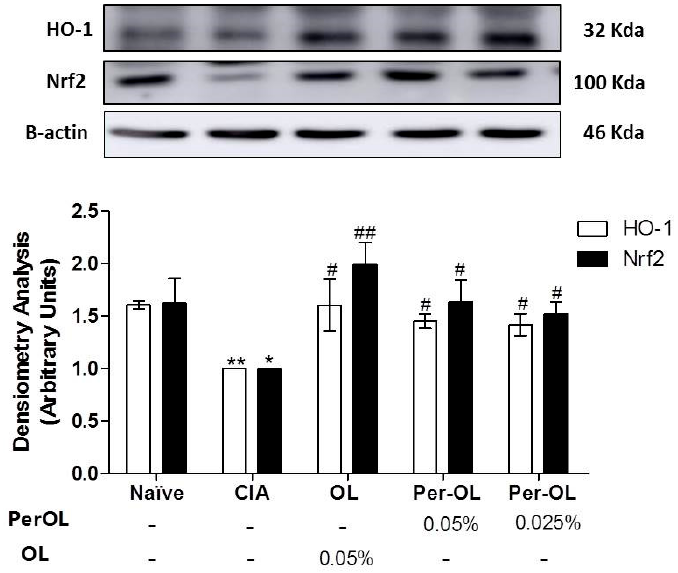
Figure 7. Effects of dietary OL and Per-OL treatment on HO-1 and Nrf2 up-regulation protein expressions in hind paws homogenates. The expression was quantified by densitometry analysis and normalized with respect to a house-keeping β -actin. Data represent mean ± S.E.M., n = 5. * p < 0.05 and ** p < 0.01 vs. SD-Naïve control group, # p < 0.05 and ## p < 0.01 vs. SD-CIA control group.